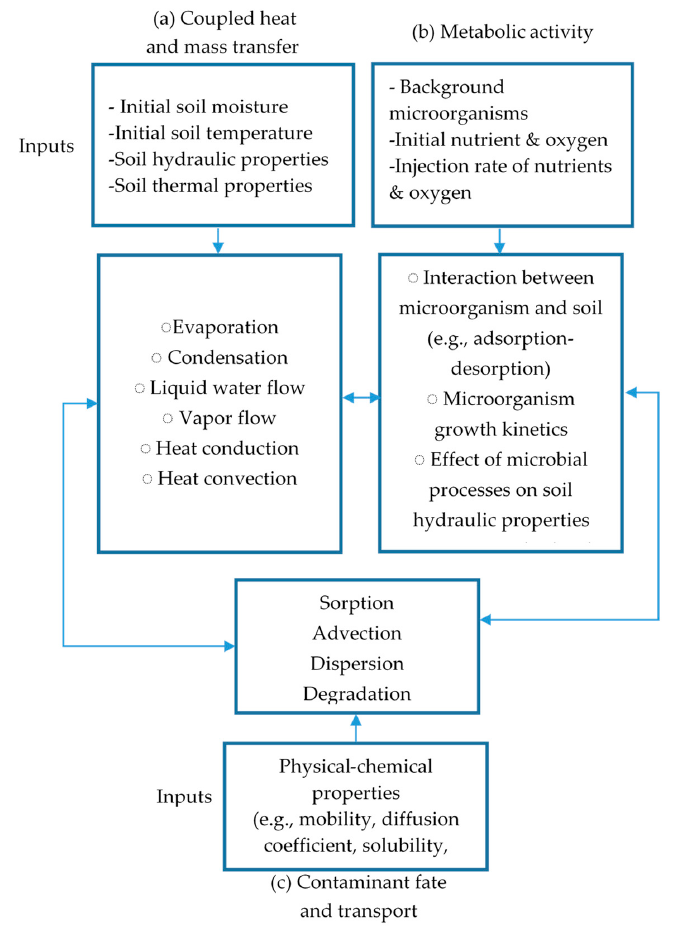
Figure 2. Mathematical modeling framework for a fully coupled thermally enhanced bioremediation– energy storage system.